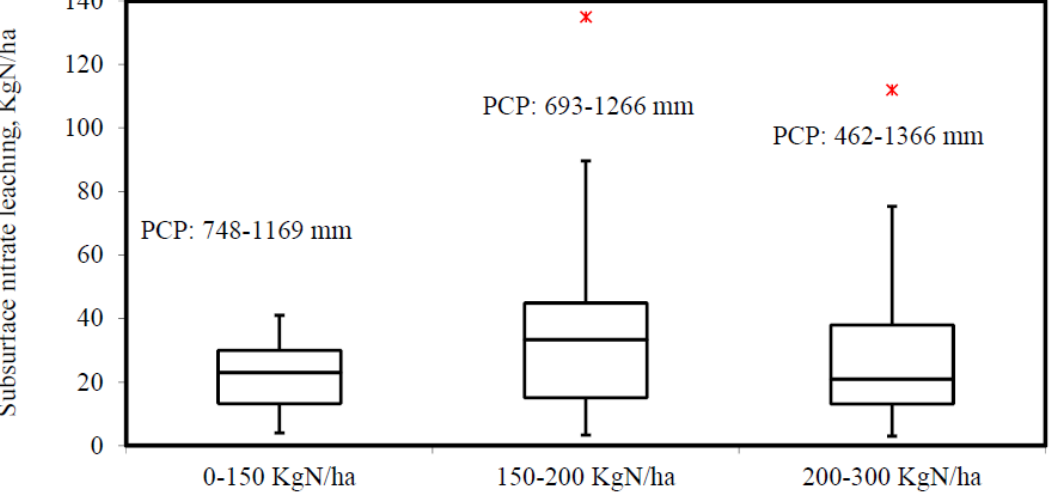
Figure 8. Subsurface nitrogen leaching from silty loam soil in rotated corn (eleven journal articles were used for analysis).